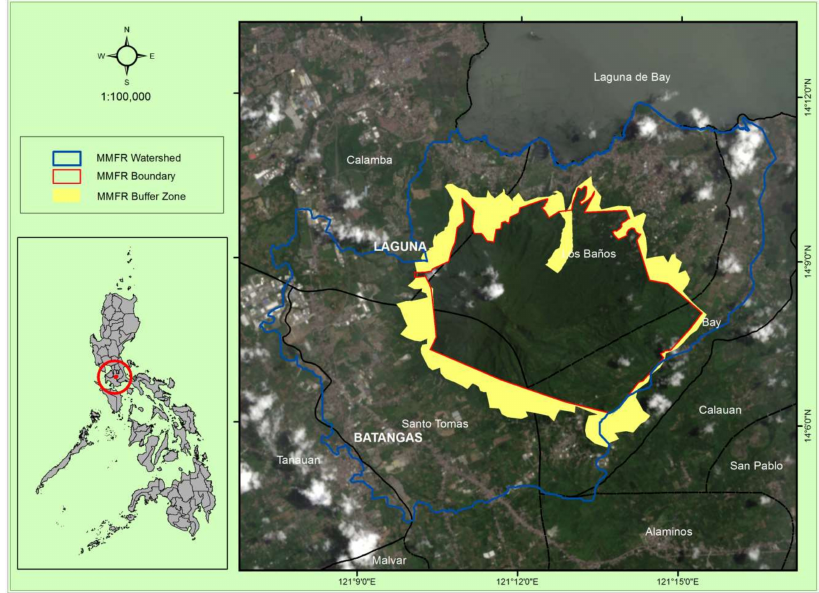
Figure 1. Geographical location of Mount Makiling Forest Reserve (MMFR) watersheds and buffer zone using the 2015 Landsat 8